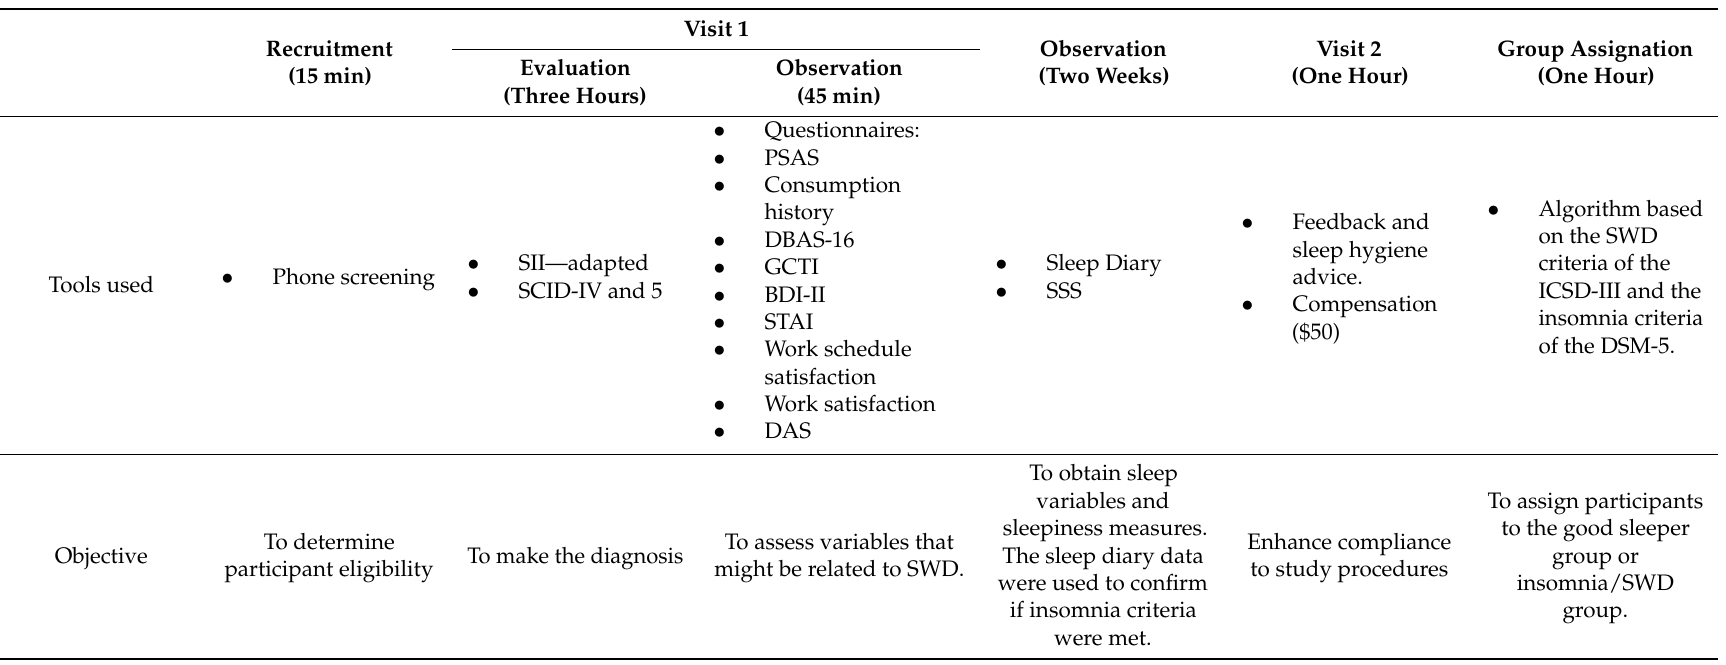
Table 2. Summary of study design, tools, and